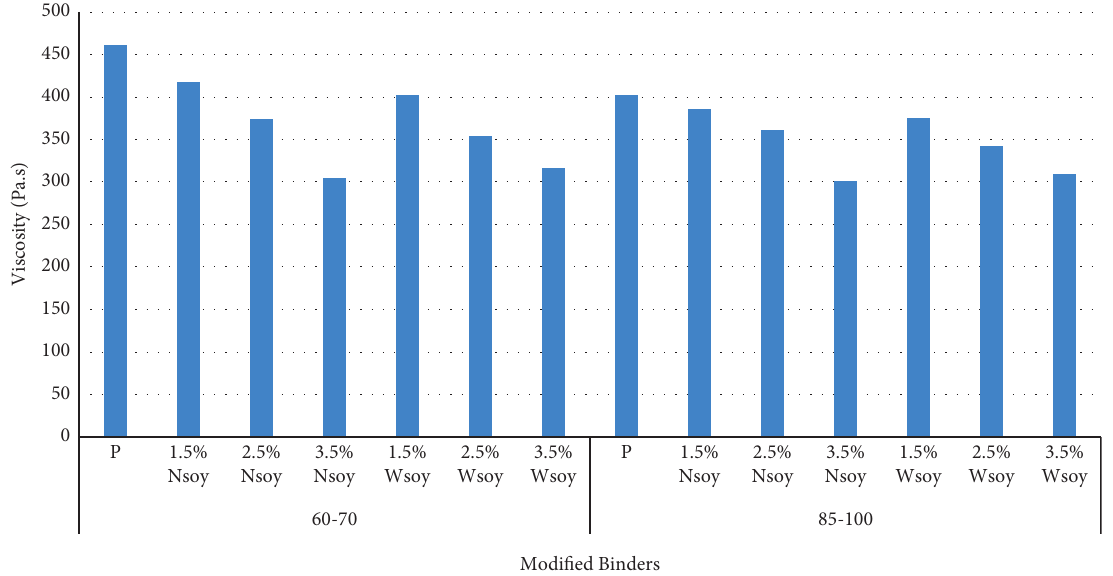
Figure 6: Rotational viscosity of unmodified and modified mixtures. Table 6: Mixing and compaction temperatures of